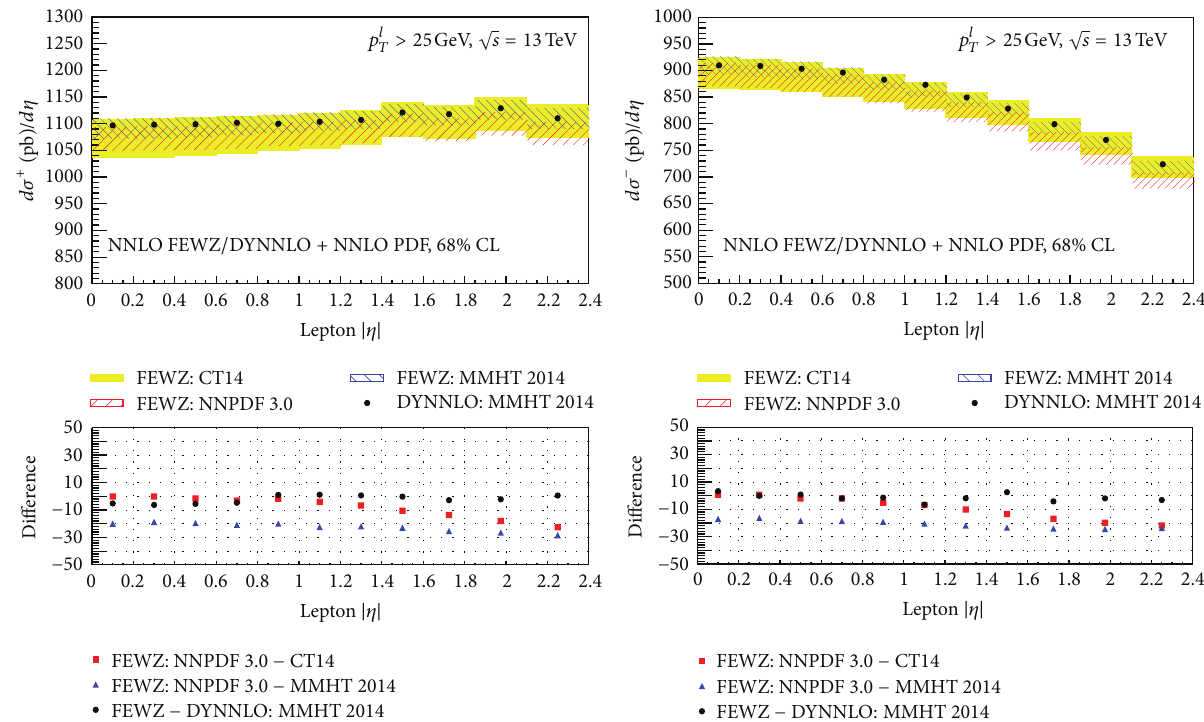
Figure 7: Predicted 𝑊 ± differential cross sections values ( 𝑑𝜎 ± /𝑑𝜂 ) as a function of muon pseudorapidity with NNLO QCD corrections. The predictions are calculated using the FEWZ 3.1 MC tool interfaced with different PDF sets (colorful bands) and they are compared with DYNNLO predictions (black points).